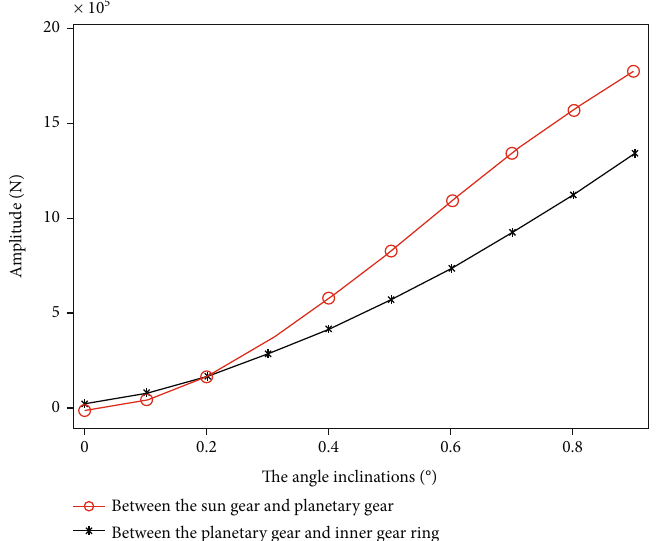
Figure 9: The variations in the average meshing force between gear pairs with di ff erent inclination